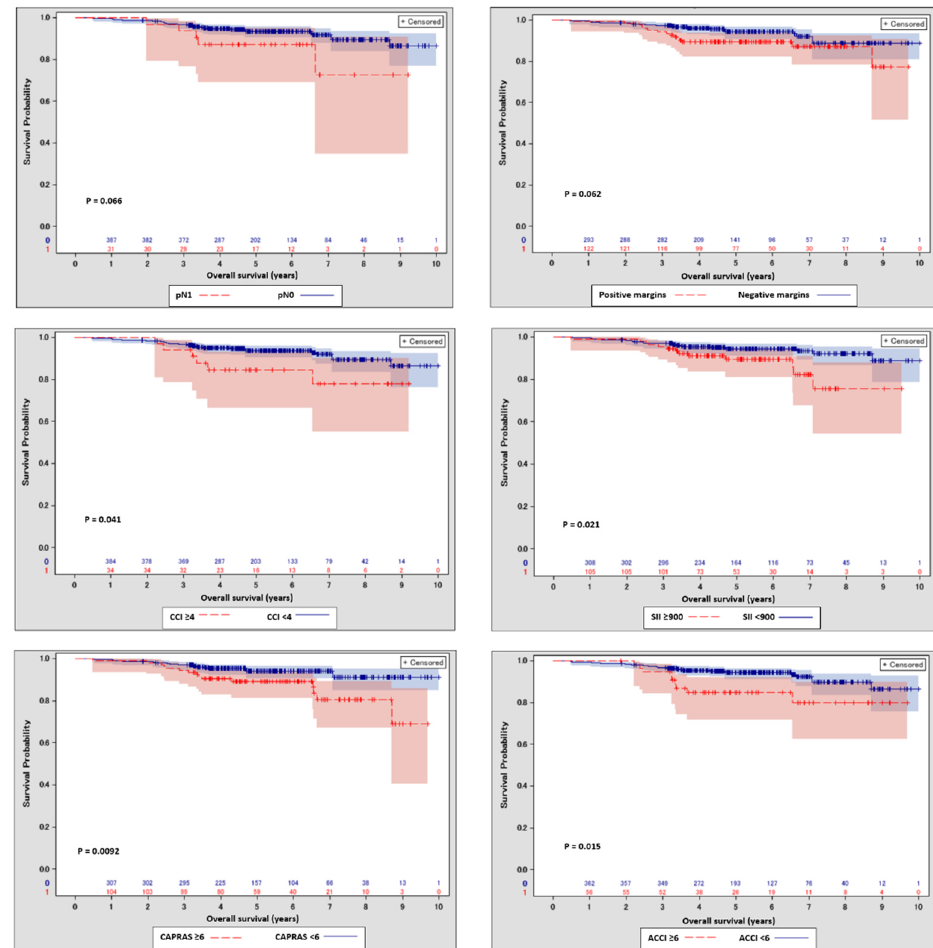
Figure 1. Kaplan-Meier curves with 95% confidence intervals for patients stratified with margin and nodal status, age-unadjusted Charlson comorbidity index ( ≥ 4) and age-adjusted Charlson comorbidity index ( ≥ 6), systemic immune-inflammation index ( ≥ 900) and CAPRA-S ( ≥ 6). Table 3. The association of SII with overall survival in patients treated with radical prostatectomy for nonmetastatic prostate cancer-multivariable Cox regression analyses, including categorized SII, CAPRA-S and age-adjusted Charlson comorbidity index (ACCI) or age-unadjusted Charlson comorbidity index